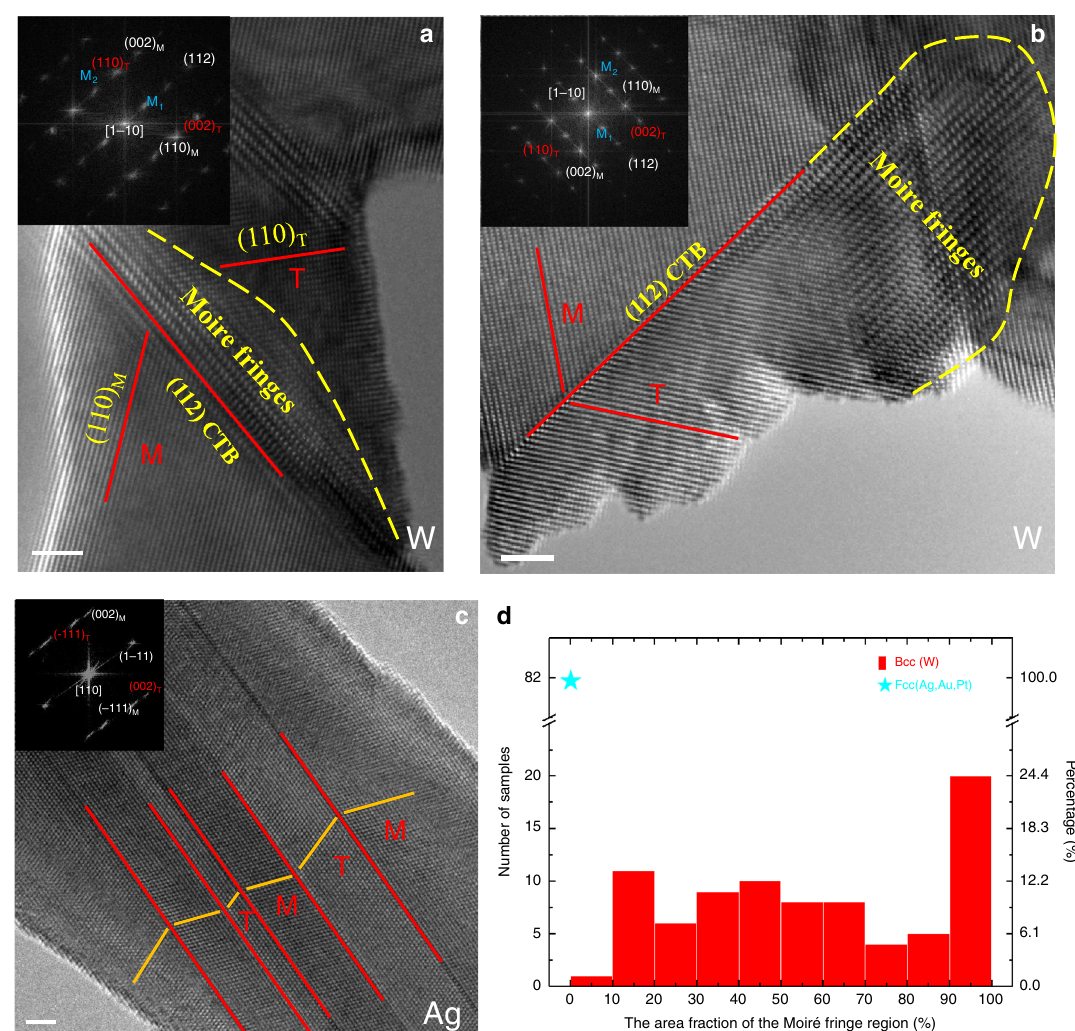
Fig. 2 Representative deformation twins in body-centered cubic metals and face-centered cubic metals. a Deformation twin with the Moiré fringe near coherent twin boundary in tungsten. b Deformation twin with the Moiré fringes near the incoherent twin boundary (the twin head) in tungsten. c Typical deformation twin in silver. Fast Fourier transform patterns proving the twin structure are inserted in the fi gure. d The sample percentage of the area fraction of the Moiré fringes in deformation twins in tungsten and face-centered cubic metals (Ag, Pt, Au). Scale bar in a – c is 2